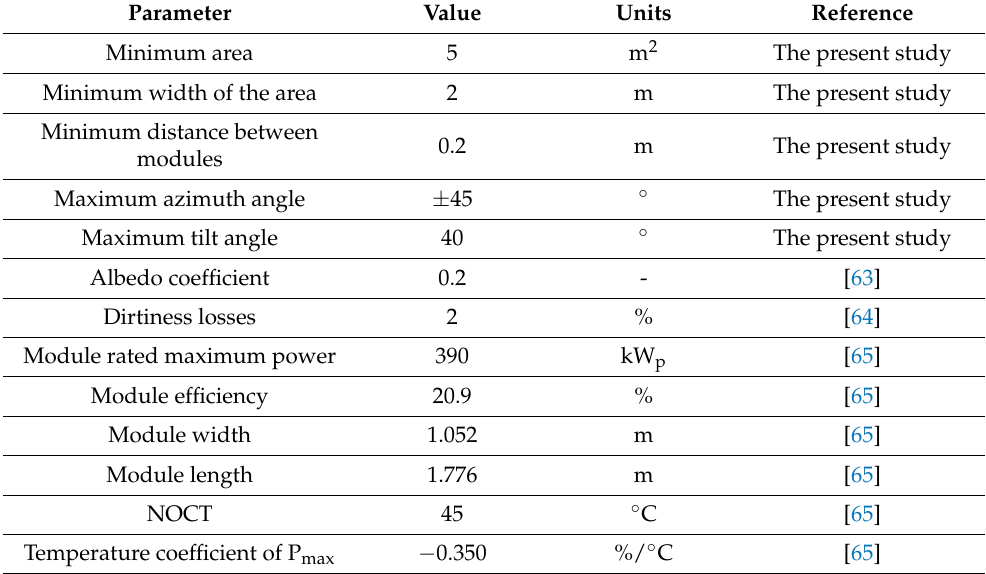
Table 4. Summary of input in the base case